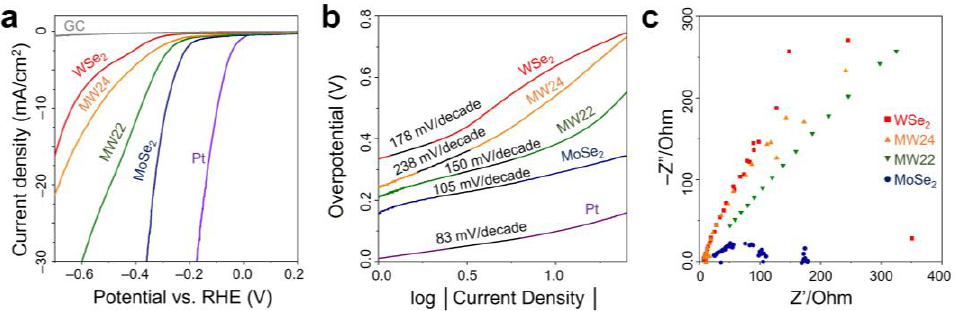
Figure 7. ( a ) Linear sweep voltammetry (LSV) analysis conducted on Pt, MoSe 2 , MW22, MW24, WSe 2 , and GC (glassy carbon) electrodes. ( b ) Tafel slopes corresponding to the LSV analysis shown